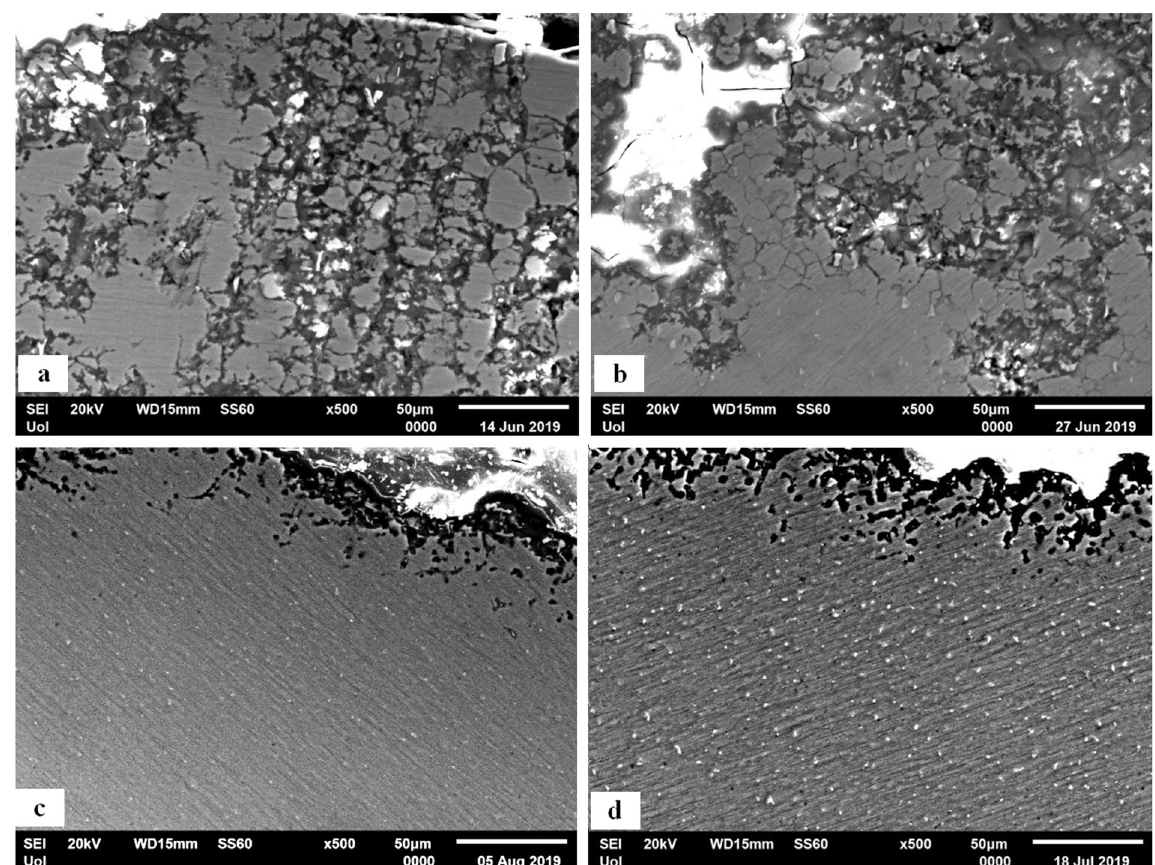
Fig. 7 Overview SEM micrographs of the corroded cross-sections. a Substrate; b Substrate-deposition interface, c Interlayer boundaries, and d Within a deposition layer.